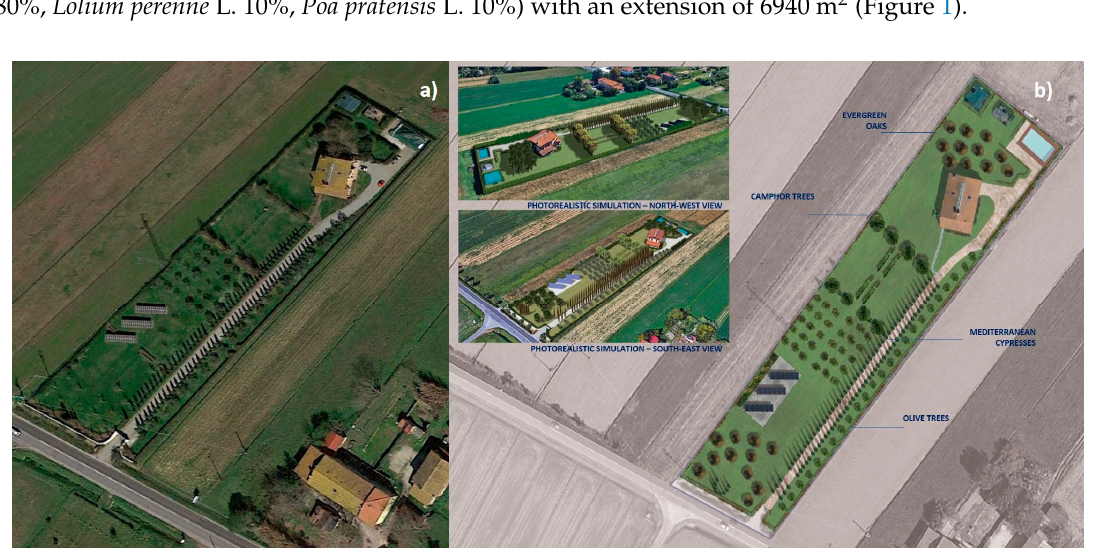
Figure 1. Comparison between: ( a ) Actual state of case study number 5; and ( b ) photorealistic rendering of case study number 5.